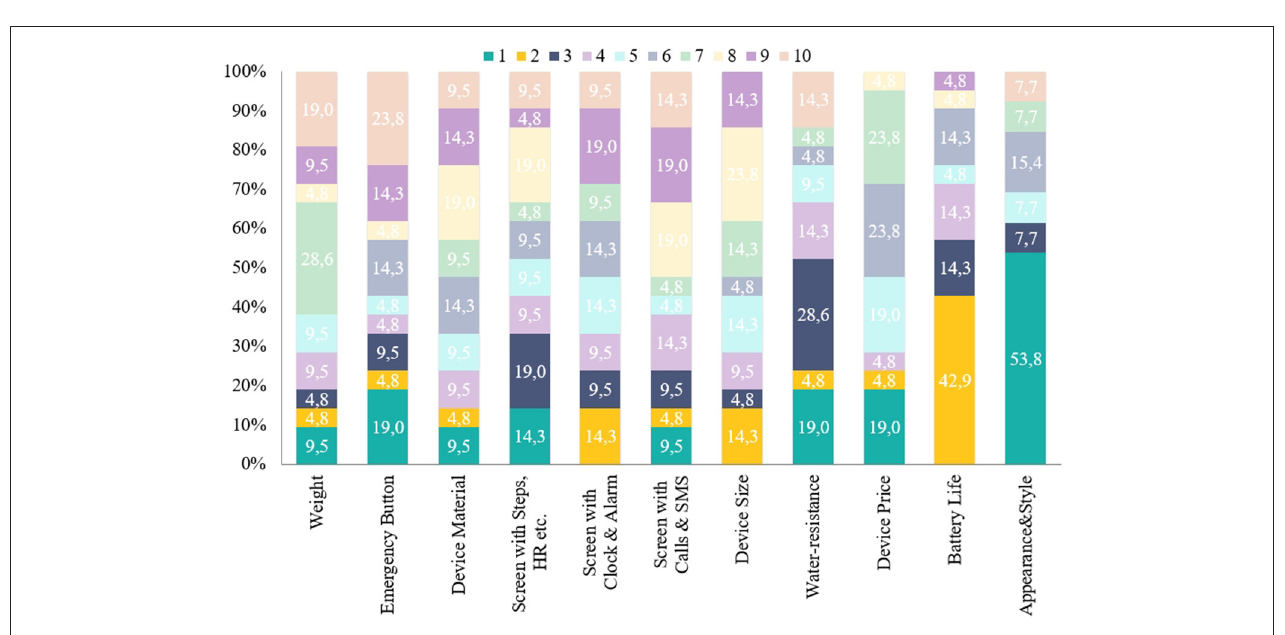
FIGURE 9 | Preferred order of features: percentage of PAB members who placed each feature in each place from 1 to 10 (most to least